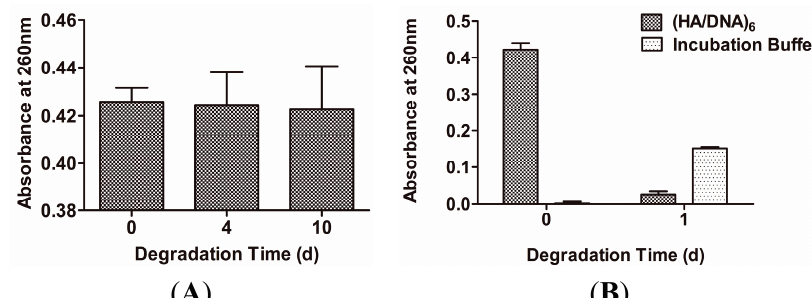
Figure 4. UV–vis absorbance of (HA/DNA) 6 films and incubation buffer at 260 nm as function of time after incubation in ( A ) PBS at 37 °C, pH 7.4 ( n = 3) and ( B ) the trypsin solution (0.1 mg/mL in PBS buffer) at 37 °C, pH 7.4 ( n =